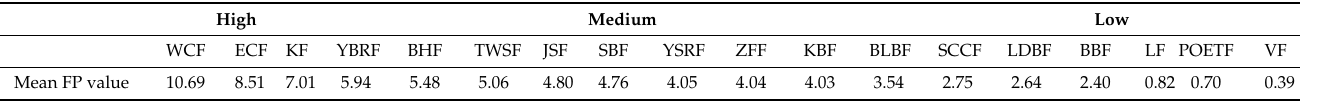
Table 3. The mean FP value of each frontal area and the frequency of each front.